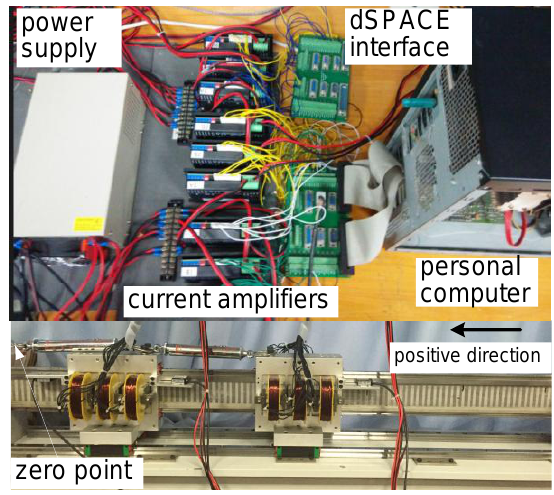
Figure 4. Experimental force control setup.